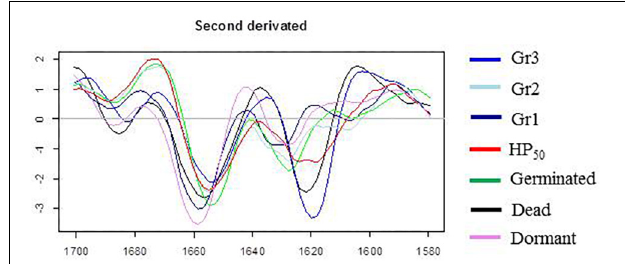
FIGURE 7 | Second derivative of the mean infrared spectra (1,700–1,580 cm − 1 ) of control spore samples (germinated; dead; dormant) and spores treated by high pressure (HP) at 500 MPa for 10 min at 50 ◦ C or 20 ◦